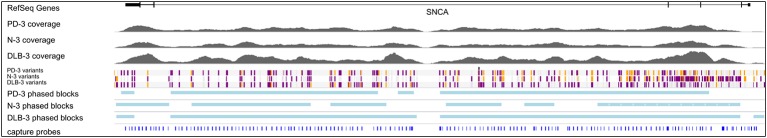
Targeted gDNA capture and phasing. An example showing one sample from each condition. Top track shows one of the SNCA isoforms, followed by the gDNA coverage for the three samples. The variant track shows each SNP and are color-coded for heterozygous (purple), homozygous alternative (orange), and homozygous reference (gray). Phased blocks are shown in light blue. Bottom track shows capture probe locations. The dropout region in probe design is due to two LINE elements in the middle of intron 4. For the gDNA coverage and phasing information of all 12 samples, see Supplementary Figures.